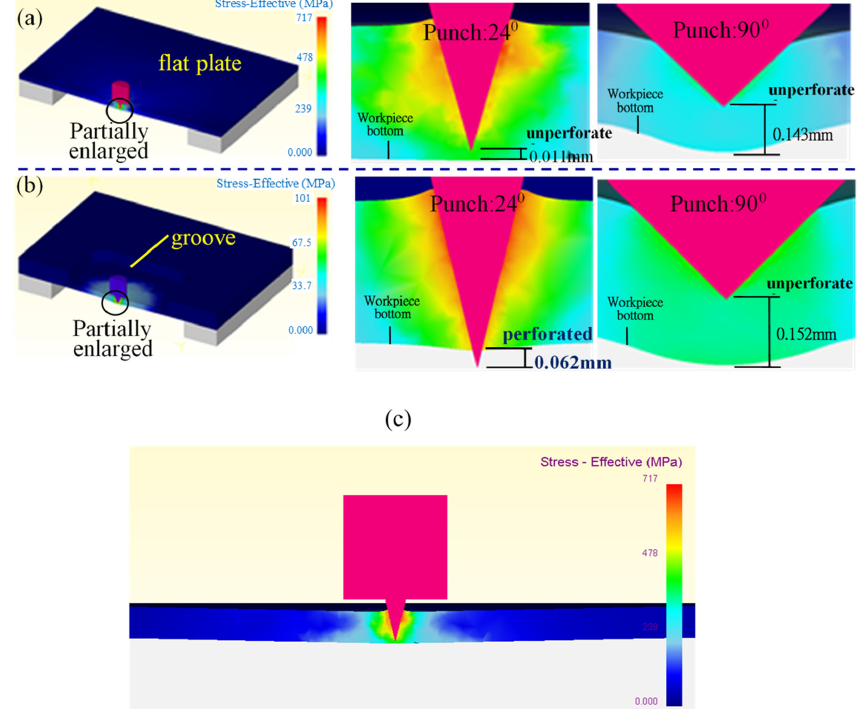
Figure 4. Schematic diagram of workpiece shape/punch angle in punch forming ( a ) workpiece-flat plate ( b ) workpiece ‐ grooved ( c ) deflection of flat plate with a 24° punch head.